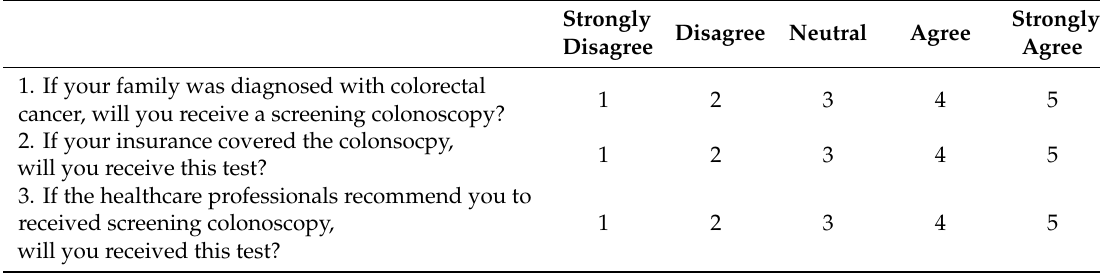
Table A3. Cues to Action